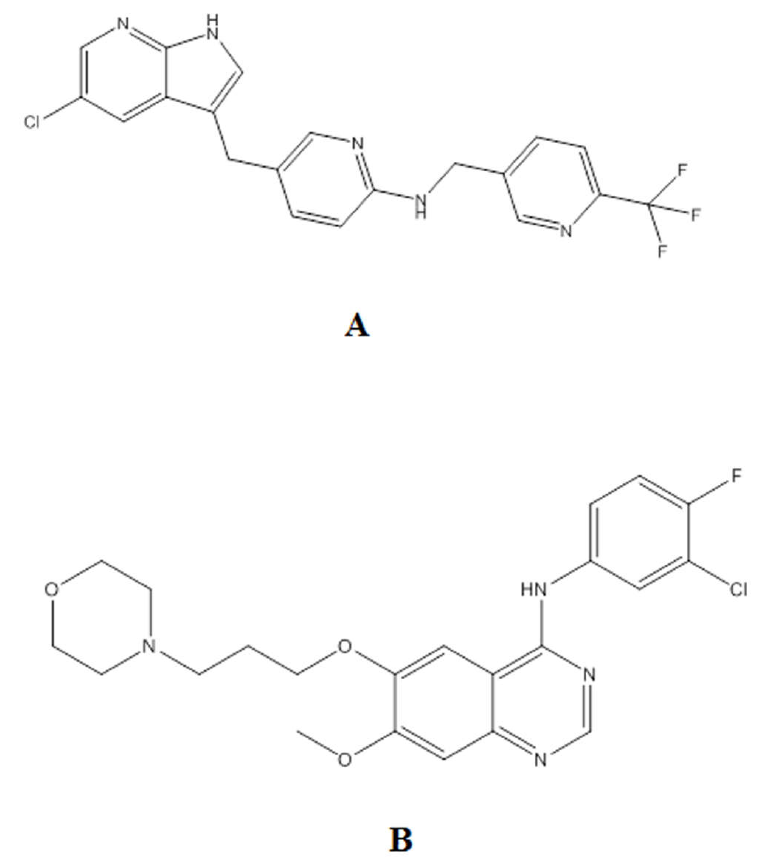
Figure 1. Chemical structure of PX ( A ) and IS ( B ).